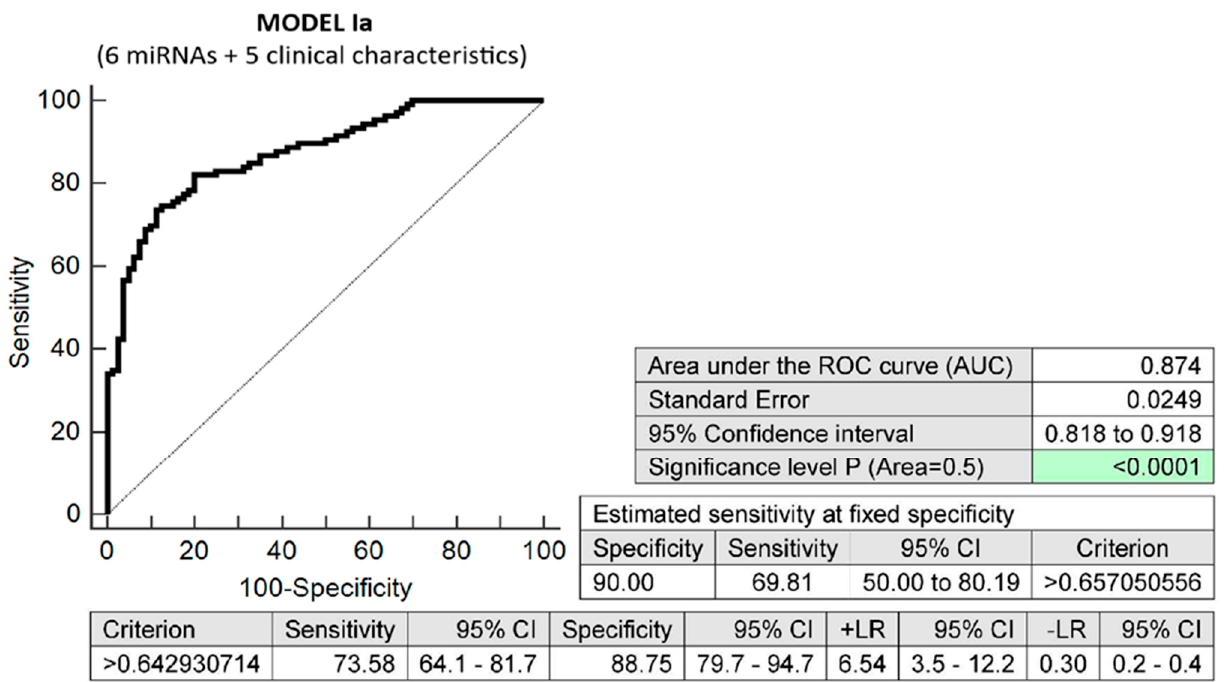
Figure 1. ROC analysis—prediction model Ia for preterm birth before 37 gestational weeks. Five clinical characteristics (age and body mass index values at first trimester of gestation, treatment of infertility by techniques of assisted reproduction, preterm birth < 37 gestational weeks in previous pregnancy(ies), and the presence of any kind of autoimmune disease (RA, SLE, APS, T1DM, or other autoimmunity)) combined with six microRNAs with aberrant expression profiles (miR-16-5p, miR-21-5p, miR-24-3p, miR-133a-3p, miR-155-5p, and miR-210-3p). In total, 69.81% of pregnancies destined to deliver before 37 weeks of gestation were identified during the first trimester of gestation with a 10.0%